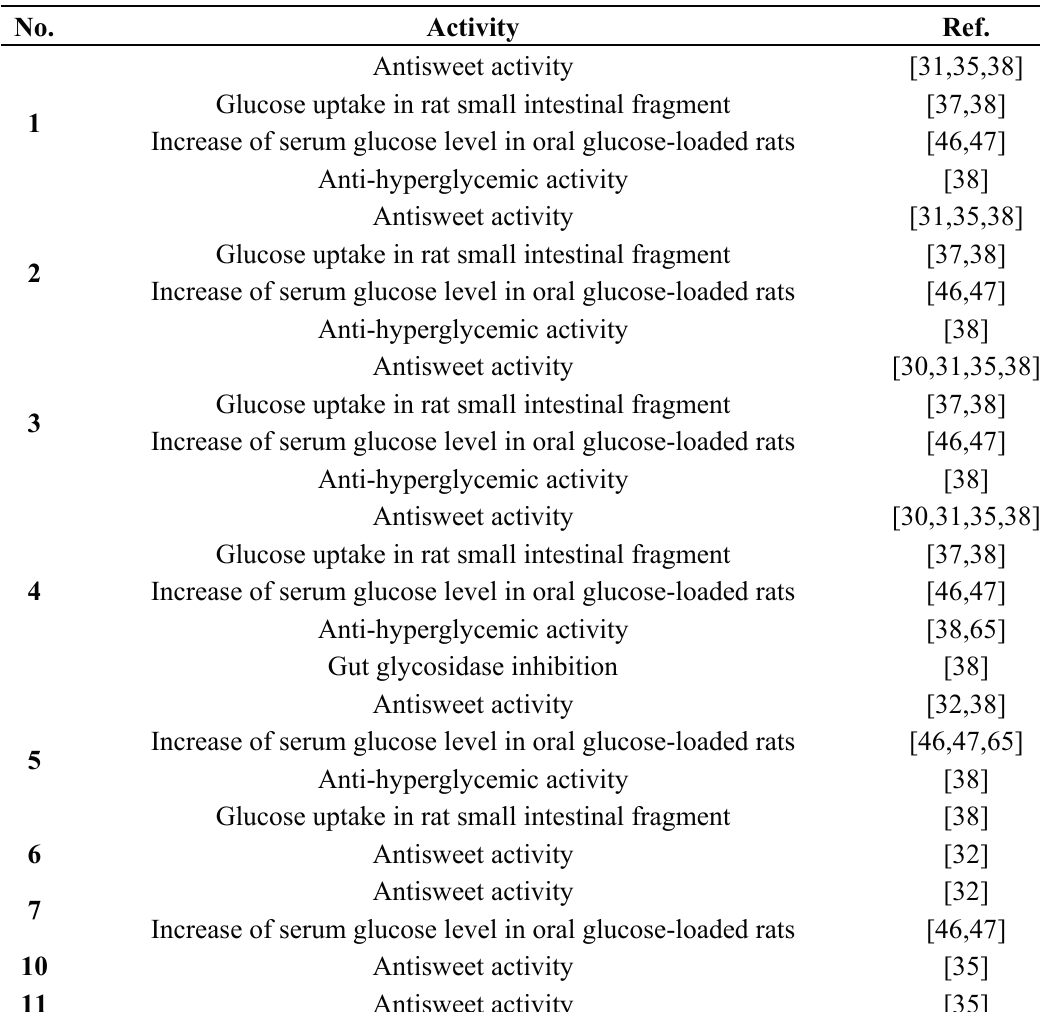
Table 5. Biological properties associated with the triterpenes with a focus on their potential chemotherapeutic